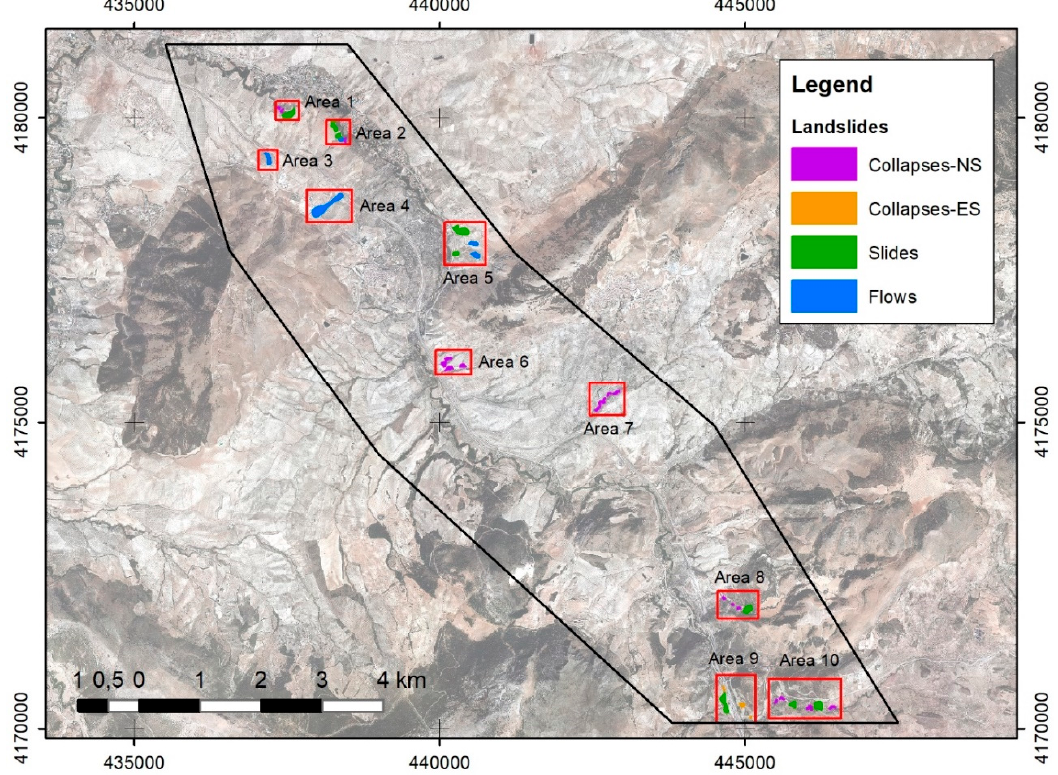
Figure 6. Monitoring areas. Coordinates are in ETRS89 ‐ UTM30.